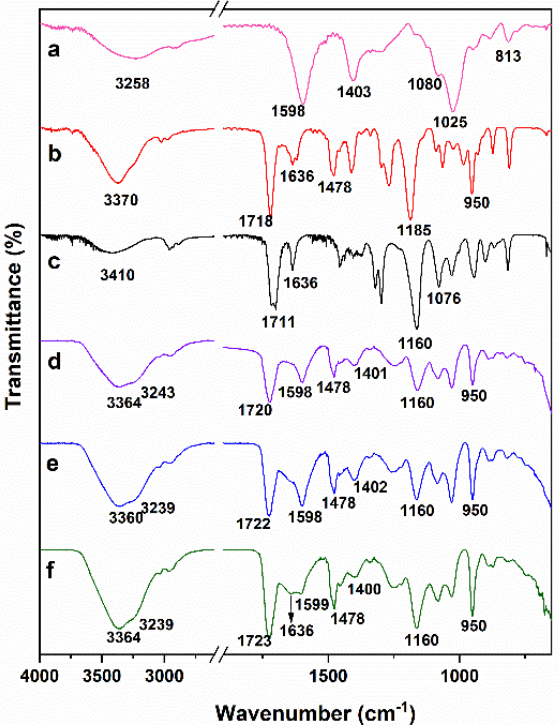
Figure 2. FTIR spectra of AlgNa ( a ), QCL ( b ), HEMA ( c ), hydrogel H2 ( d ), hydrogel H4 ( e ), and hydrogel H6 ( f ).